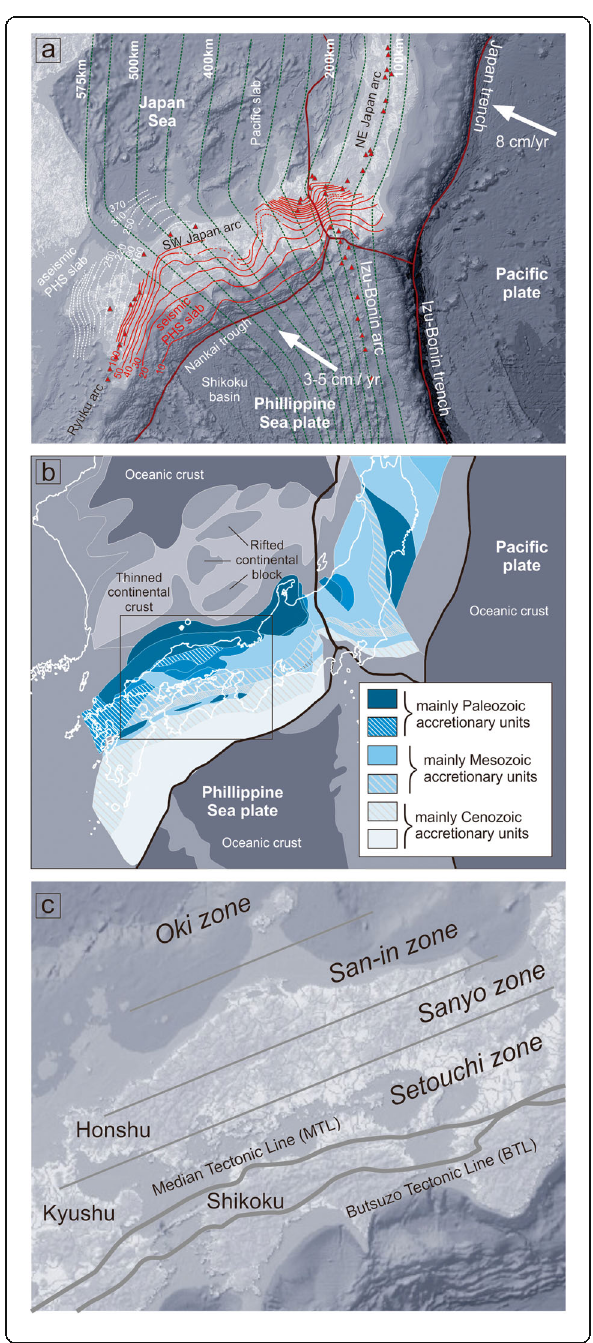
Fig.1 a Tectonic setting, showing individual arc segments and subduction zones of the Japanese island arc system (Kimura et al. 2014). Notice the distinct trench morphology between the NE Japan arc and the SW Japan arc. Seismic tomography shows the deep slab of the Pacific plate (in green) and the Philippine Sea Plate (red – seismic, white – aseismic) from Zhao et al. (2012). b : Basement geology map